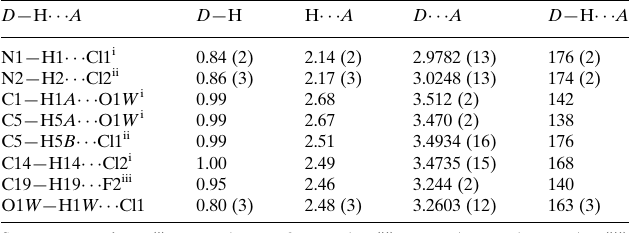
Hydrogen-bond geometry (A˚ , (cid:4)